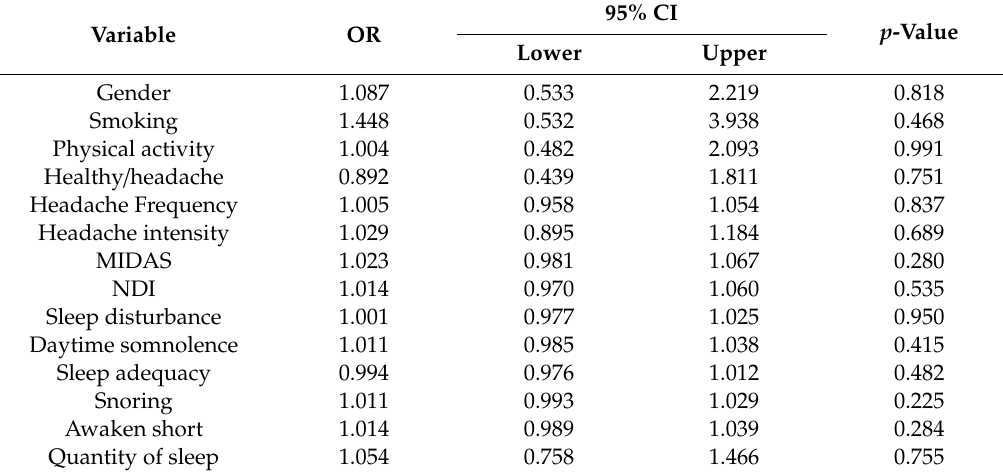
Table 2. Univariate logistic regression to analyze the factors related to alterations in the perception of verticality.